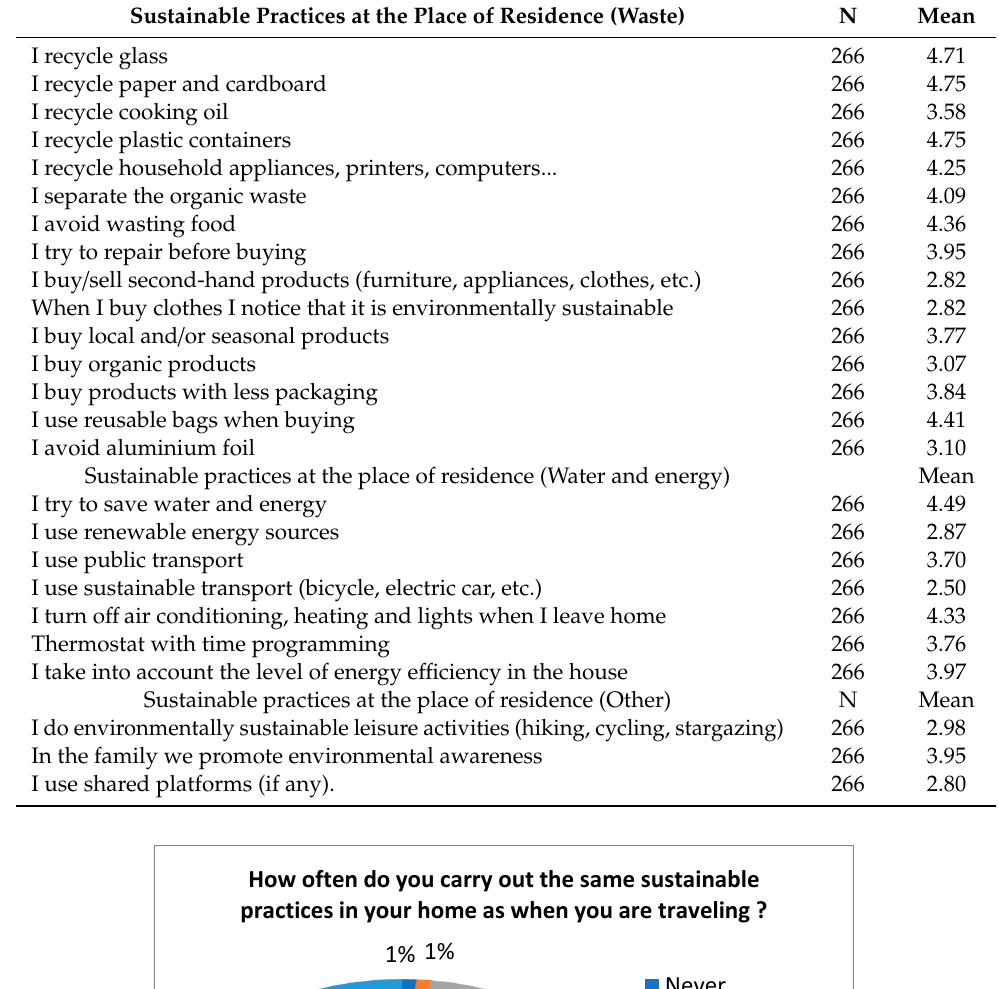
Table 14. Circular practices carried out at the tourist’s place of residence.